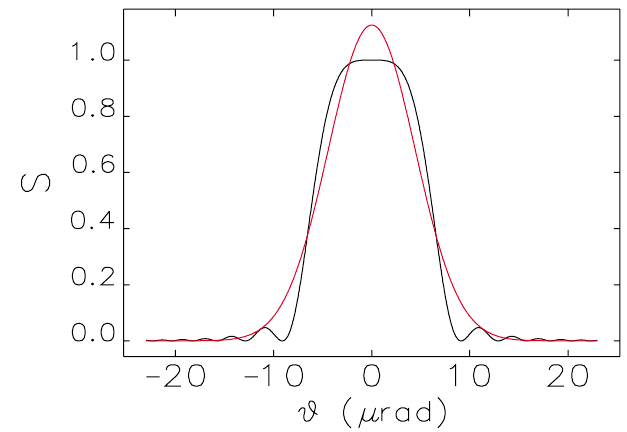
FIG. 22. (Color) The sinc-function angular distribution com- pared to a Gaussian fit, for 1 (cid:22)A radiation from a 2.4-m-long, 3.3-cm-period undulator in the